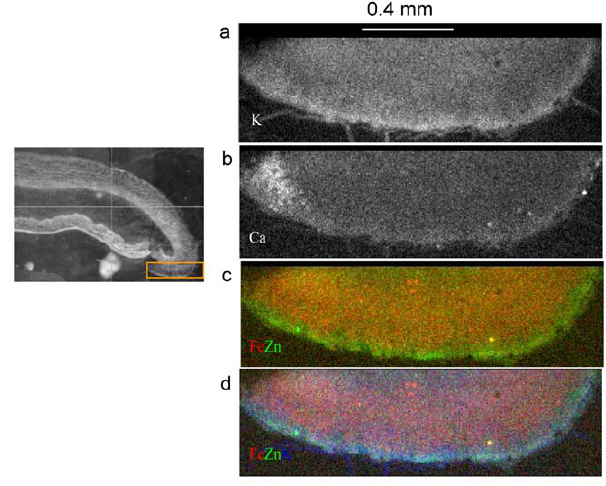
Figure 2. Comparisons of the distributions of Zn 2 + and other abundant cation species in a smaller region of gastric mucosa. Region of interest is shown in the inset (Figure 2A). The pixel size is 5 6 5 m m 2 . See text for interpretation of the color images.